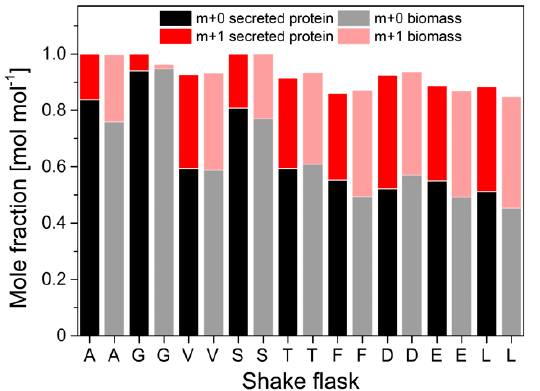
Figure 5. Molar fractions of m + 0 and m + 1 isotopomers in selected proteinogenic amino acids from hydrolyzed biomass and hydrolyzed secreted protein from H. polymorpha RB11 conphys. Cells were grown in aerobic batch culture with 5 g L − 1 100% (mol/mol) 1- 13 C glucose as the sole carbon source. Biomass and protein samples were taken in the mid-exponential growth phase after 11.5 h of total cultivation time. (A = alanine, G = glycine, V = valine, S = serine, T = threonine, F = phenylalanine, D = aspartate, E = glutamate, L = leucine) .